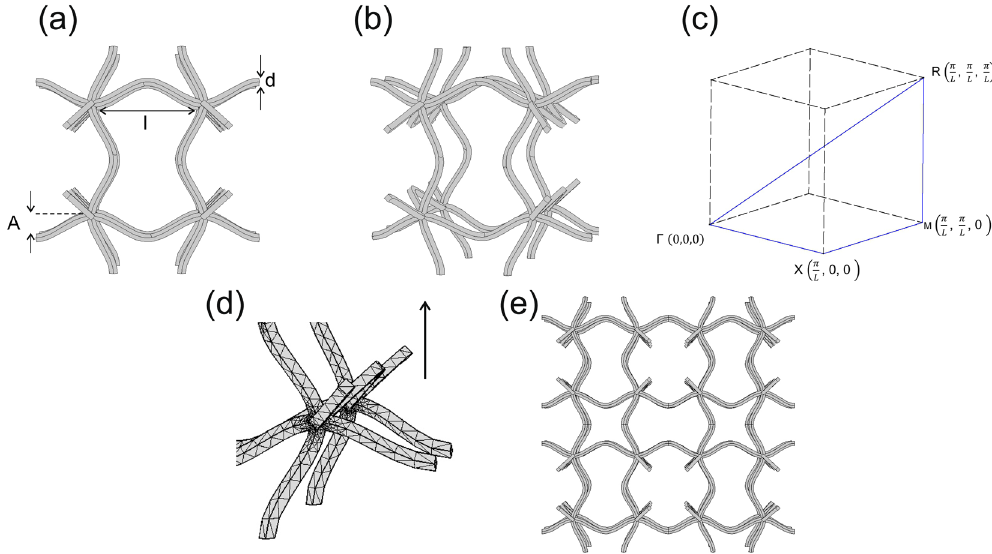
Figure 1. Unit cell: 22nd eigenmode of basic cubic unit cell: ( a ) View from xy-direction. ( b ) Slightly rotated view. ( c ) Path and corresponding coordinates in periodic